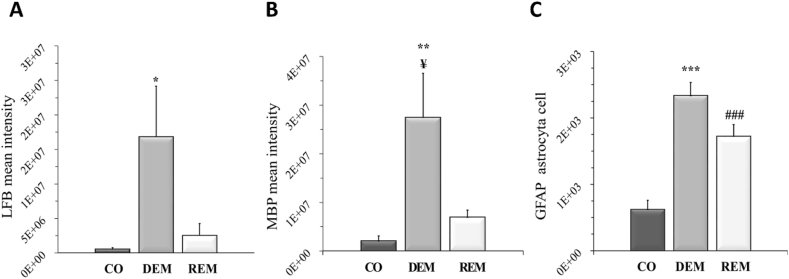
Effect of CPZ administration on myelination of the CC in the CO-, DEM- and REM group. LFB/CV (A) and MBP (B) staining for myelin content determination by intensity measurement. Immunohistochemical staining for GFAP (C) in the CC. Quantification of astrogliosis was done by manual cell counting. Our results show that the CPZ treatment caused a significant decrease in myelin content and an extensive astrogliosis in the CPZ group compared to the CO group. CC corpus callosum, CO control group, DEM demyelination group, GFAP glial fibrillary acidic protein, LFB Luxol Fast Blue, MBP myelin basic protein, REM remyelination group, ∗p < 0.05 vs. CO, ∗∗p < 0.01 vs. CO, ¥p < 0.05 vs. REM, ∗∗∗p < 0.001 vs. CO, ###p < 0.001 vs. CO.